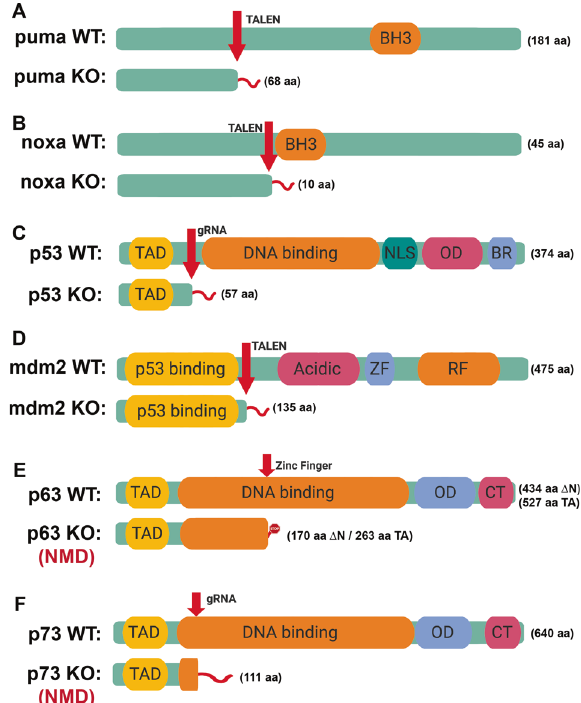
Fig. 2 The protein structure of 6 mutant alleles in zebra fi sh generated by zinc fi nger, TALEN, or CRISPR-Cas9 gene editing. A Schematic of Puma wild-type and mutant proteins. (BH3, BH3 domain). B Schematic of Noxa wild-type and mutant proteins. C Schematic of p53 wild-type and mutant proteins. TAD transactiva- tion domain, DNA-binding DNA-binding domain, NLS